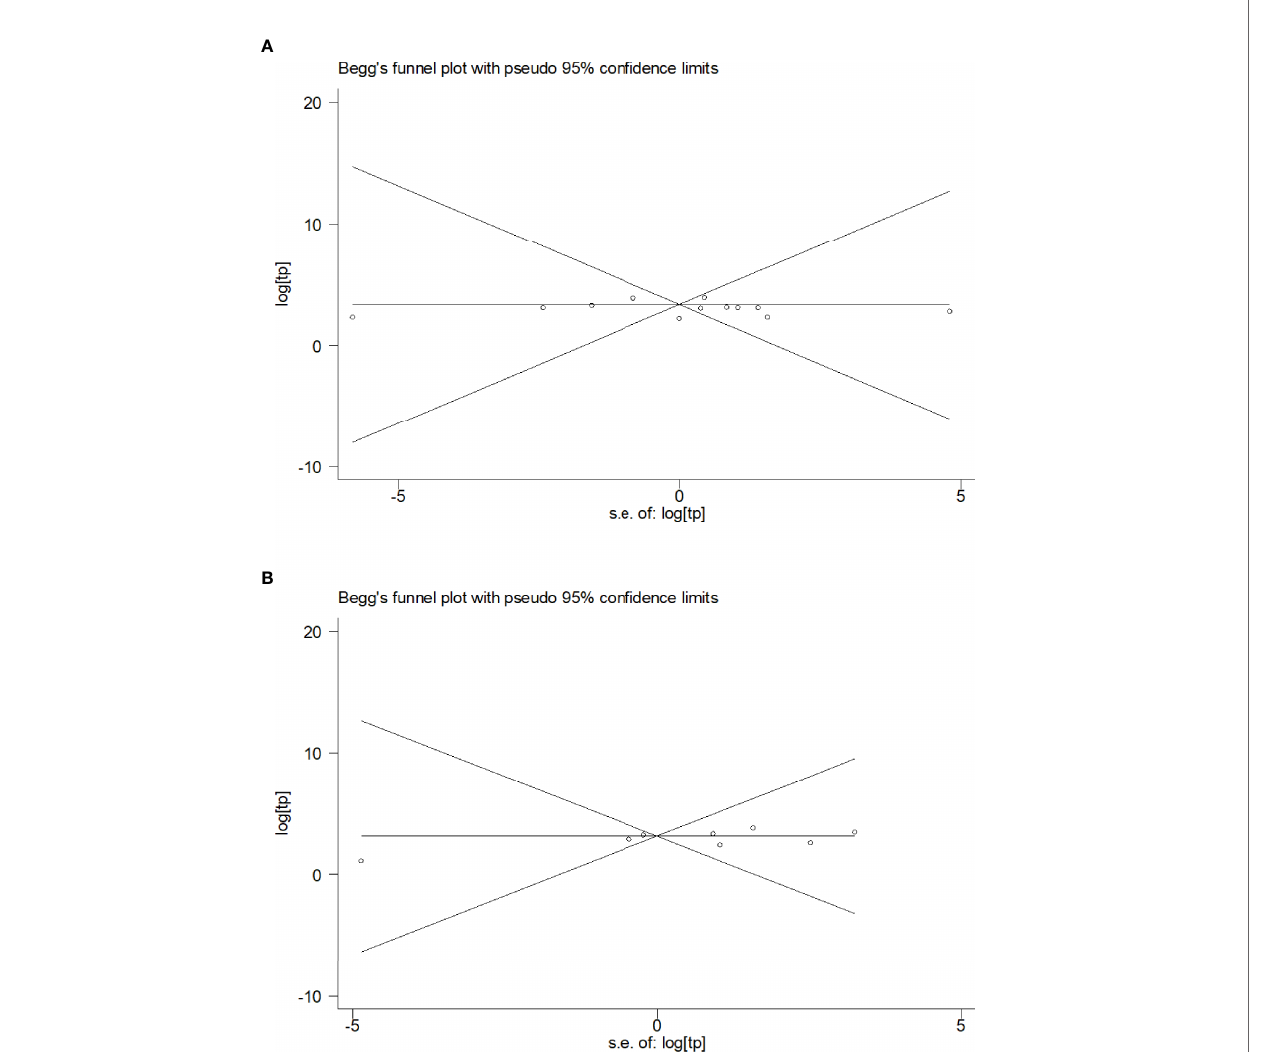
FIGURE 4 | Funnel plot of the included studies. (A) Funnel plots of the included studies on blood (A) and CSF samples (B)